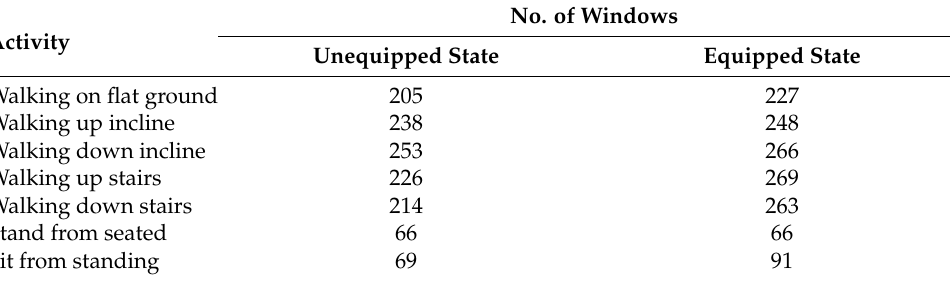
Table 3. Number of windows per